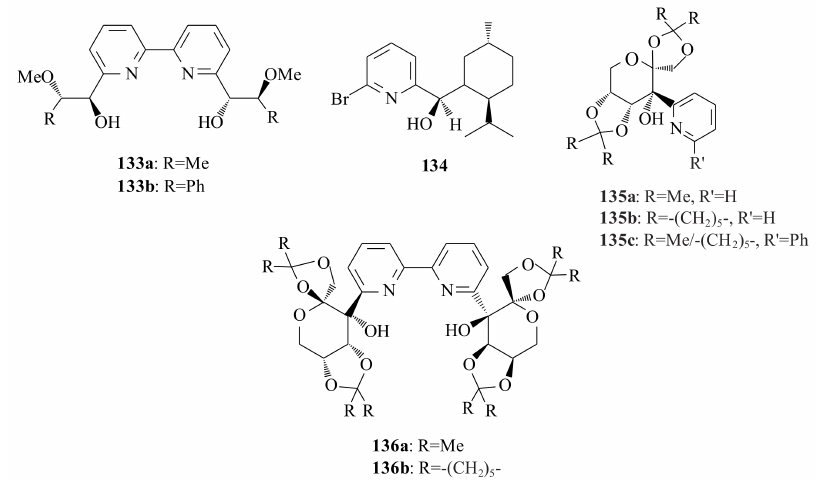
Figure 27. Complex pyridinyl alcohols used in the diethylzinc addition